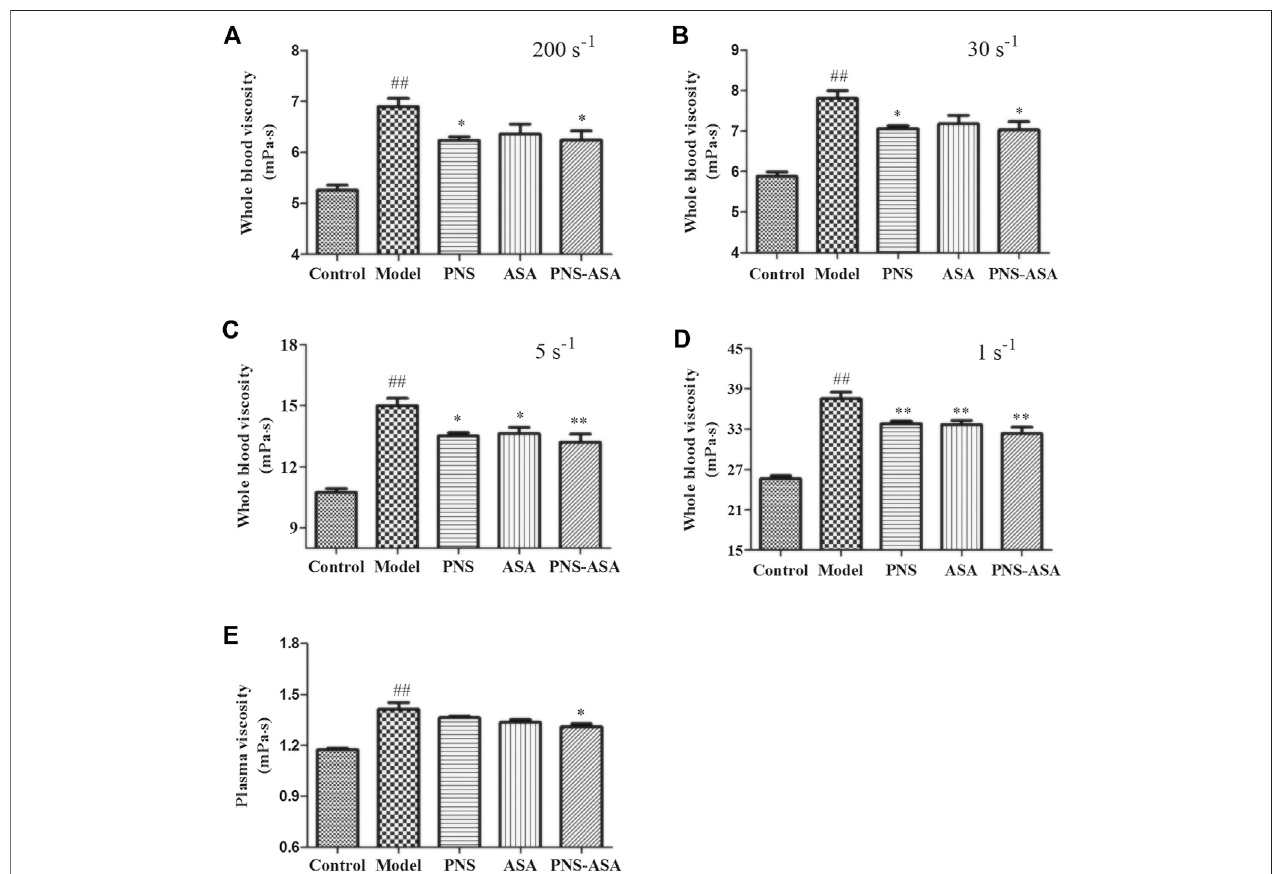
FIGURE2| EffectsofcombineduseofPNSandASAonwholebloodviscosityandplasmaviscosityinratswithacutebloodstasis. (A – D) Thewholebloodviscosity wasmeasuredattheshearratesof200 s − 1 ,30 s − 1 ,5 s − 1 ,and1 s − 1 inorder; (E) Theplasmaviscosityofeachtestedgroup.Datawererepresentedasmean ± SD( n (cid:2)